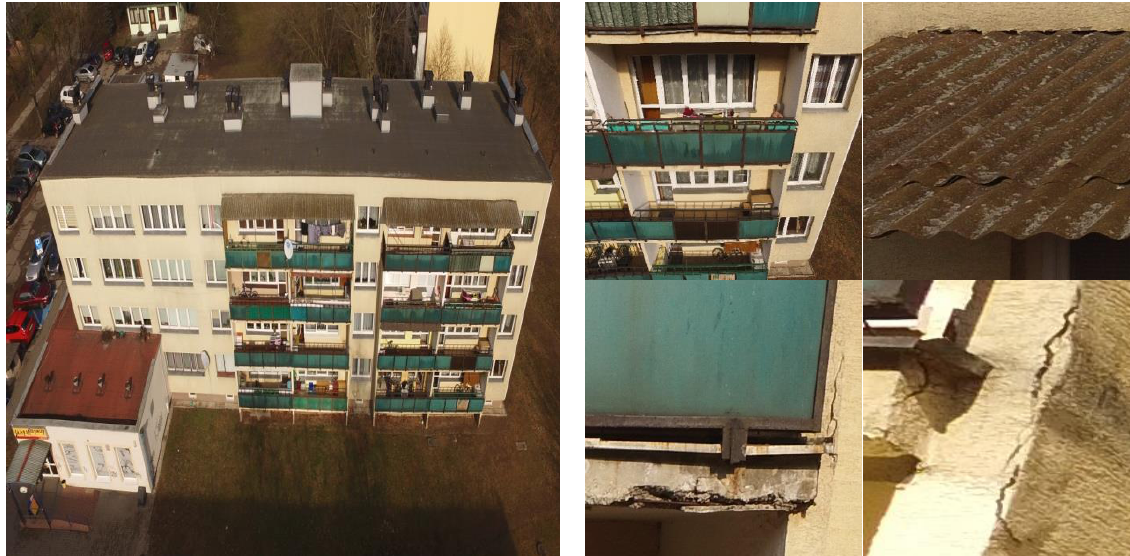
Figure 1: General view and four specific details of one of the facades in the sample.